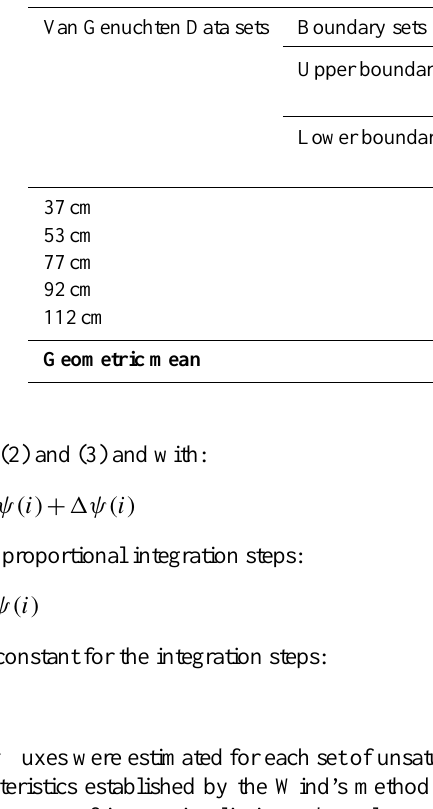
Table 3. Steady state fluxes (cm) for 35 days, computed using Eqs. (5) and (3) with three different sets of boundary conditions and five soil data sets (Table 2). (in bold: geometric mean). Z 1 is the depth of upper limit (cm), Z 2 the depth of lower limit (cm). 2 1 and 2 2 are the water contents at depths Z 1 and Z 2 . 2 s is the saturated water content, and ψ(2 1 ), the potential head (cm) at the depth Z 1 . Sets i , ii and iii correspond to integration boundaries representative of field